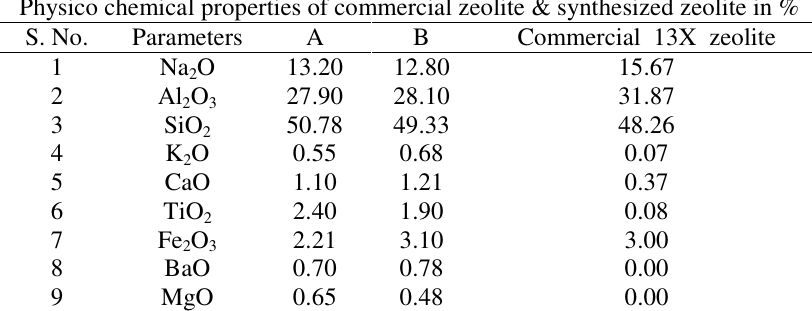
Table 3. Physico chemical properties of commercial zeolite & synthesized